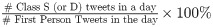
Trend in postings of life satisfaction tweets over one-year period.X axis: week. Y axis: Percentage computed as # Class S (or D) tweets in a day# First Person Tweets in the day×100%.